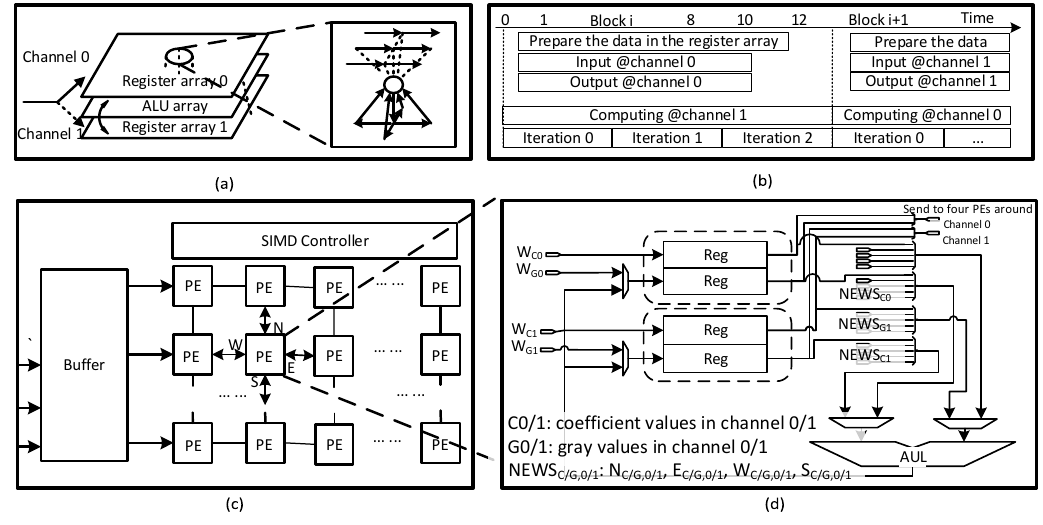
Figure 7. ( a ) Data flow of the Ping-Pong operations. The arithmetic operations and data preparation are done in parallel; ( b ) Typical timing sequence to process one block; ( c ) Diagrams of B-DTCNN array in which PEs are connected in North, South, East and West (NEWS) directions to communicate data during iterations; ( d ) Inner structure of each PE that caches coefficient values and gray values of two channels in local registers.